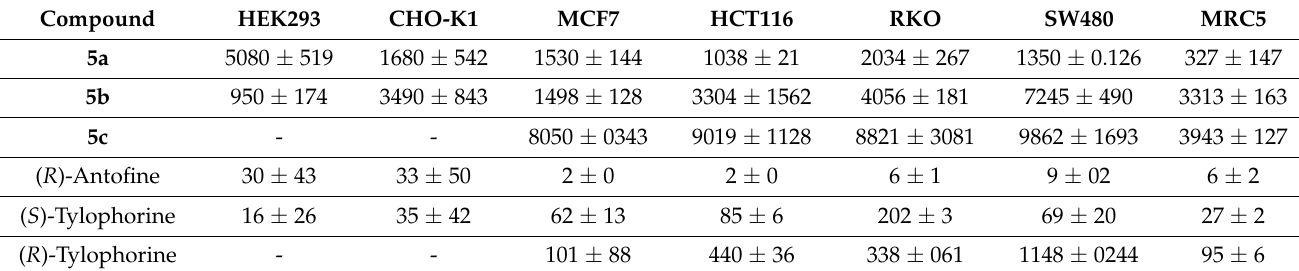
Table 4. Cytotoxicity of compounds 5a – c and their parent alkaloids under normoxia (nM, IC 50 ).